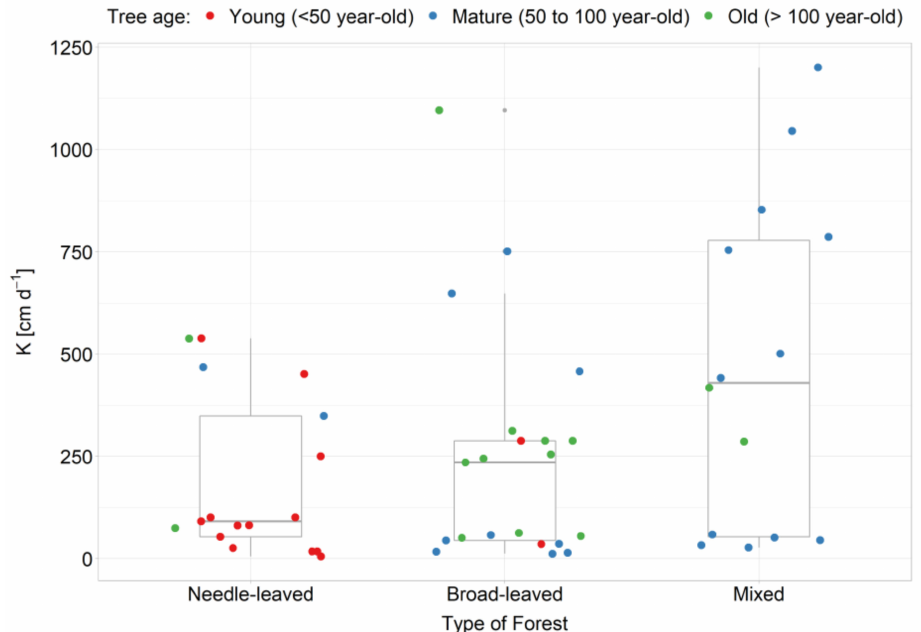
Figure 6. Descriptive statistics of top mineral soil hydraulic conductivity for dataset B in relation to tree age and forest type. Scattered points represent the individual values classified by the different forest stages considered in this study. Values correspond to the 0–30 cm soil depth. Grey points represent the outliers.